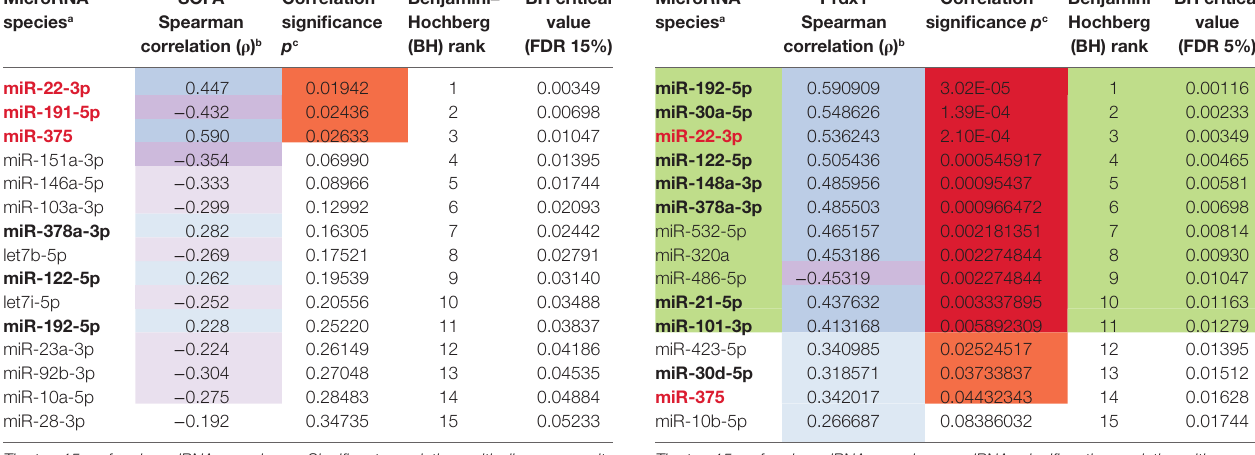
The top 15 performing miRNAs are shown. Significant correlations with disease severity are highlighted in bold black (SIRS) or red (sepsis). Refer to Table S5 in Supplementary Material for the full dataset. a Green-shadowed cells indicate miRNAs that passed the BH correction for multiple comparisons. b Blue- and violet-shadowed cells indicate miRNAs that returned positive and negative correlations ( ρ ≥ 0.2 or ρ ≤ − 0.2), respectively. c Brown- and red-shadowed cells indicate miRNAs that returned significant correlations (p ≤ 0.05) and additionally passed the correction for multiple comparisons,